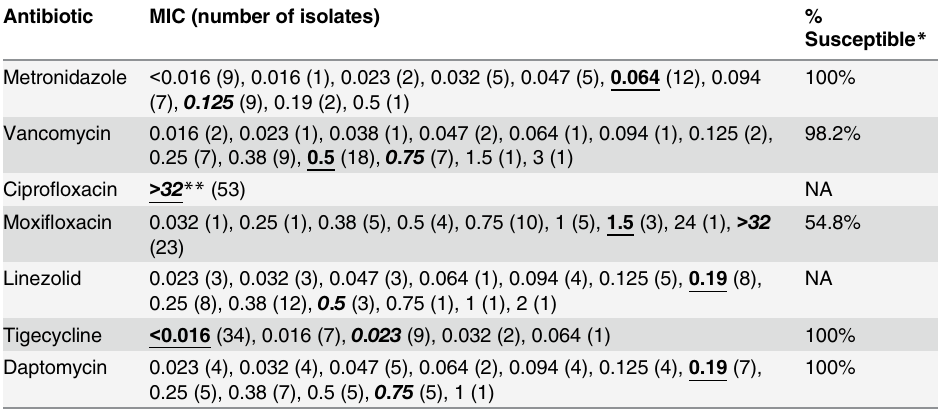
Table 2. Susceptibility to various antibiotics of C . difficile isolates in this study ( μ g/mL). Antibiotic MIC (number of